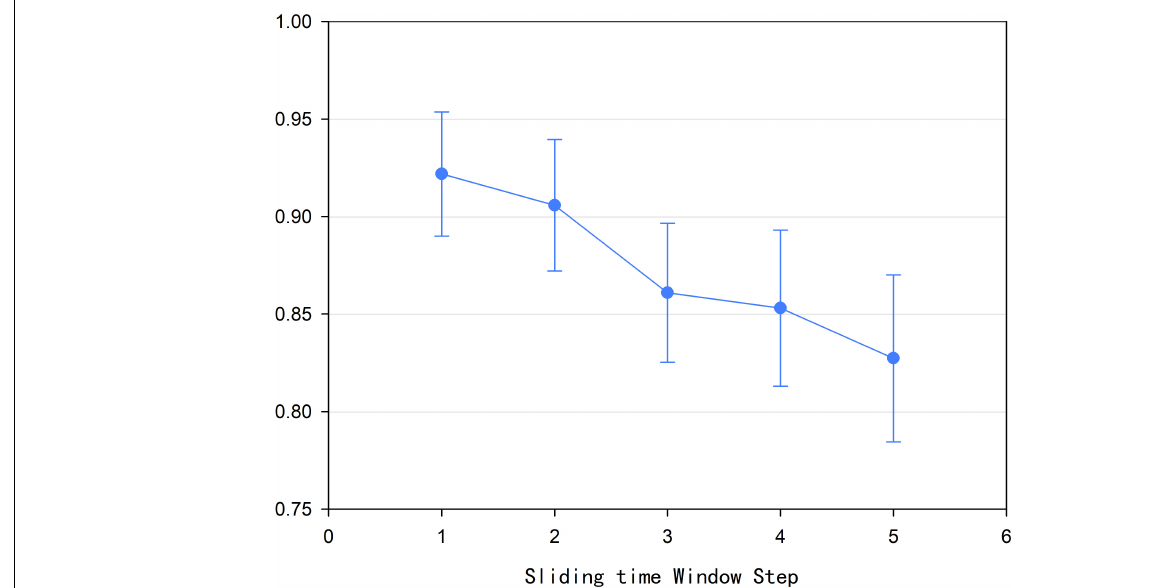
FIGURE 9 | Classification accuracy of different moving steps.